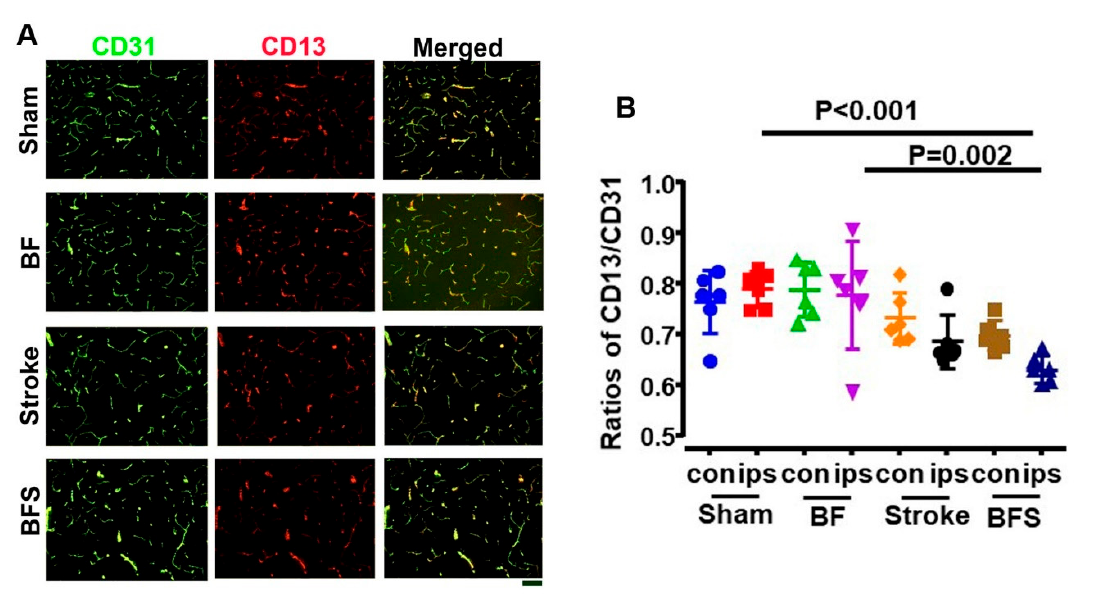
Figure 4. BF reduced vascular pericyte converge in the hippocampi ipsilateral to the stroke injury. ( A ). Representative images of sections stained with antibodies specific to CD31 (green) and CD13 (red). Scale bar: 50 µm. ( B ). Quantification for the ratios of CD13 + /CD31 + cells. The groups represented by different colors are indicated on the X-axis. N = 6. con: contralateral to stroke injury. ips: ipsilateral to stroke injury. BFS: BF 6 h before stroke.